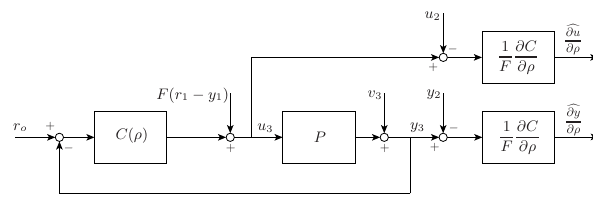
Figure 3. Block diagram of modified closed-loop gradient experi- ment for reference inputs with